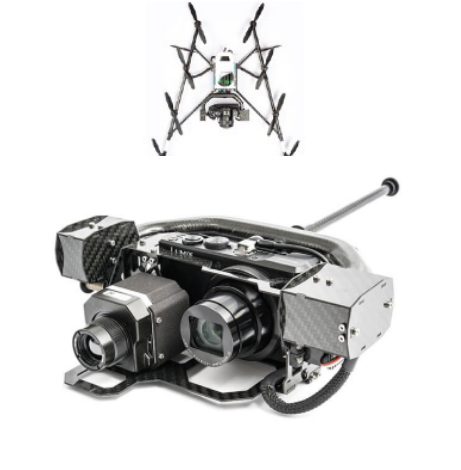
Figure 1. Asctec Falcon 8 and Gimbal with FLIR Tau